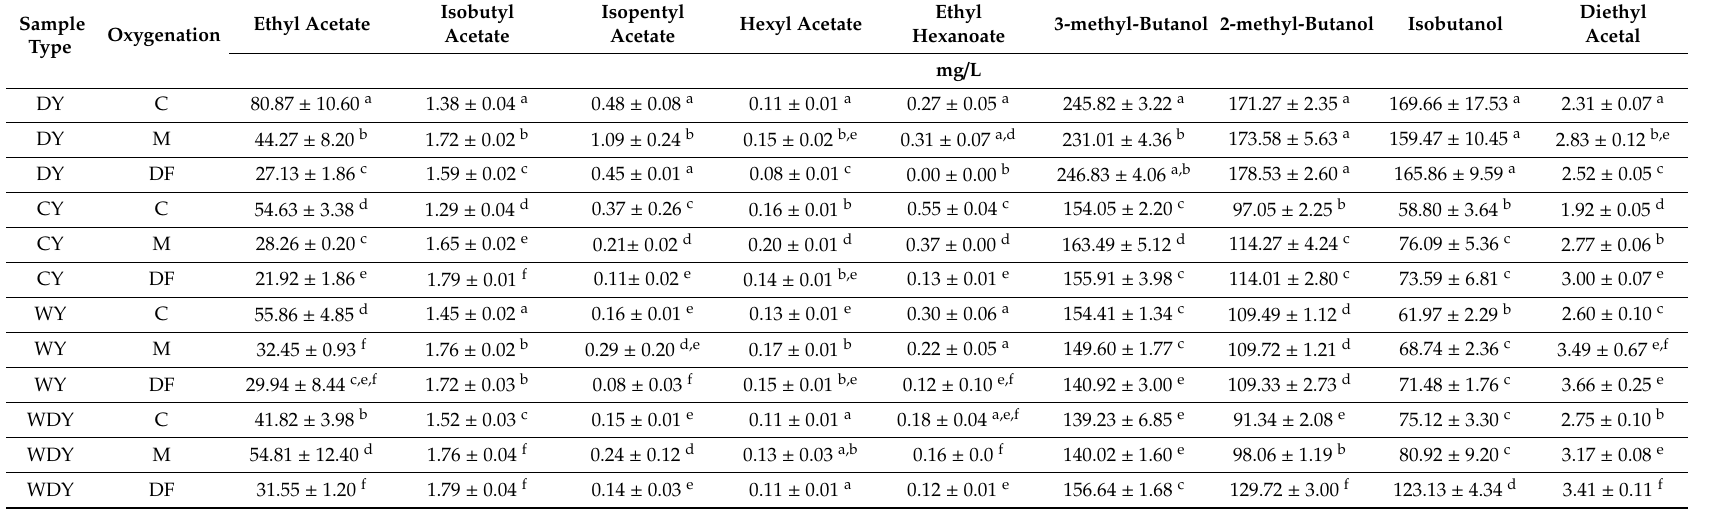
Table 3. Impact of the type of oxygenation on volatile compounds concentration in